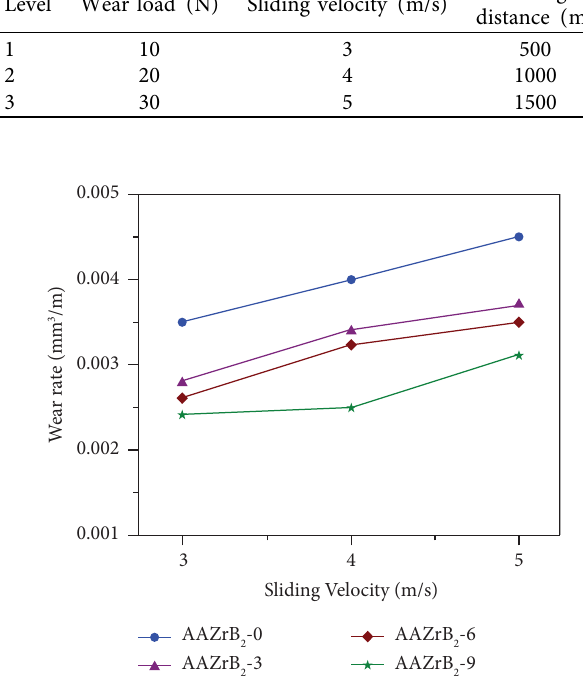
Figure 1: Based on sliding velocity, the wear rate of pure and hybrid composite.